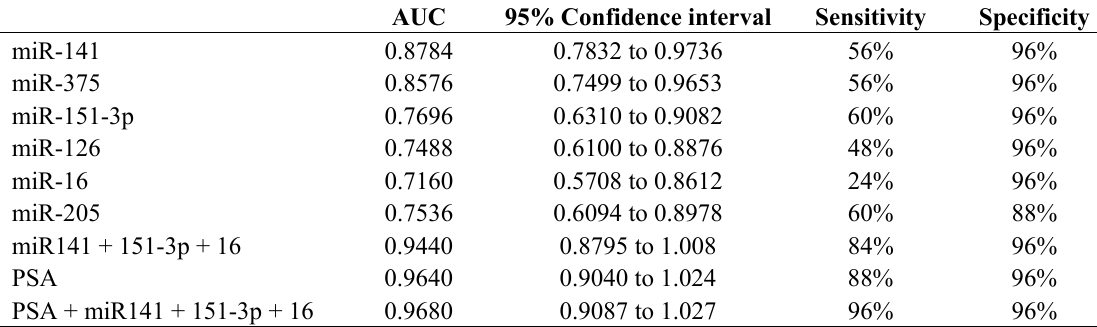
Table 2. ROC analysis to assess the specificity and sensitivity of individual or pairs of miRNAs to differentiate between localized PCa and mCRPC. Sensitivity and specificity refer to the threshold value with the highest likelihood